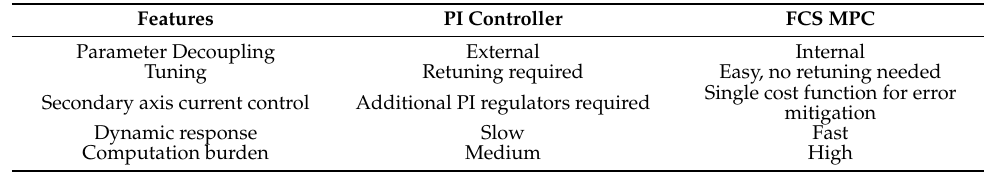
Table 5. Comparison of FCS-MPC and classical PI